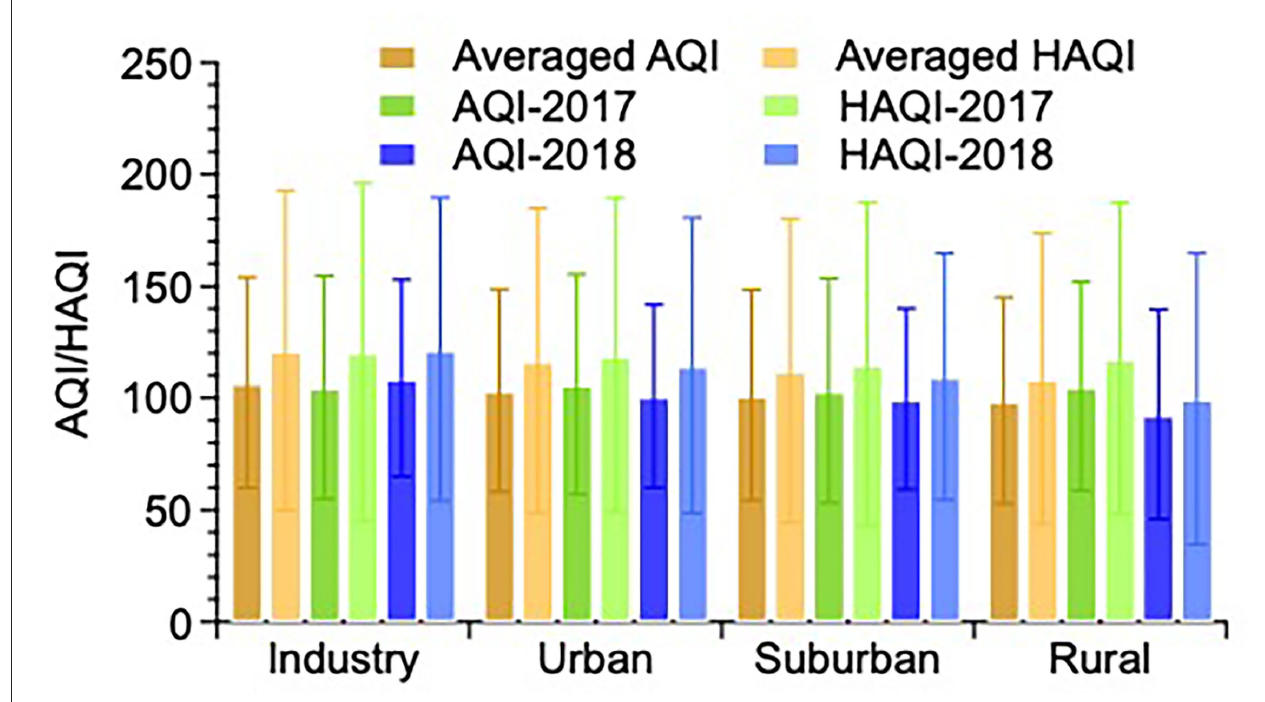
FIGURE4 The mean AQI and HAQI average over 2017 and 2018 in four functional areas in Jining.